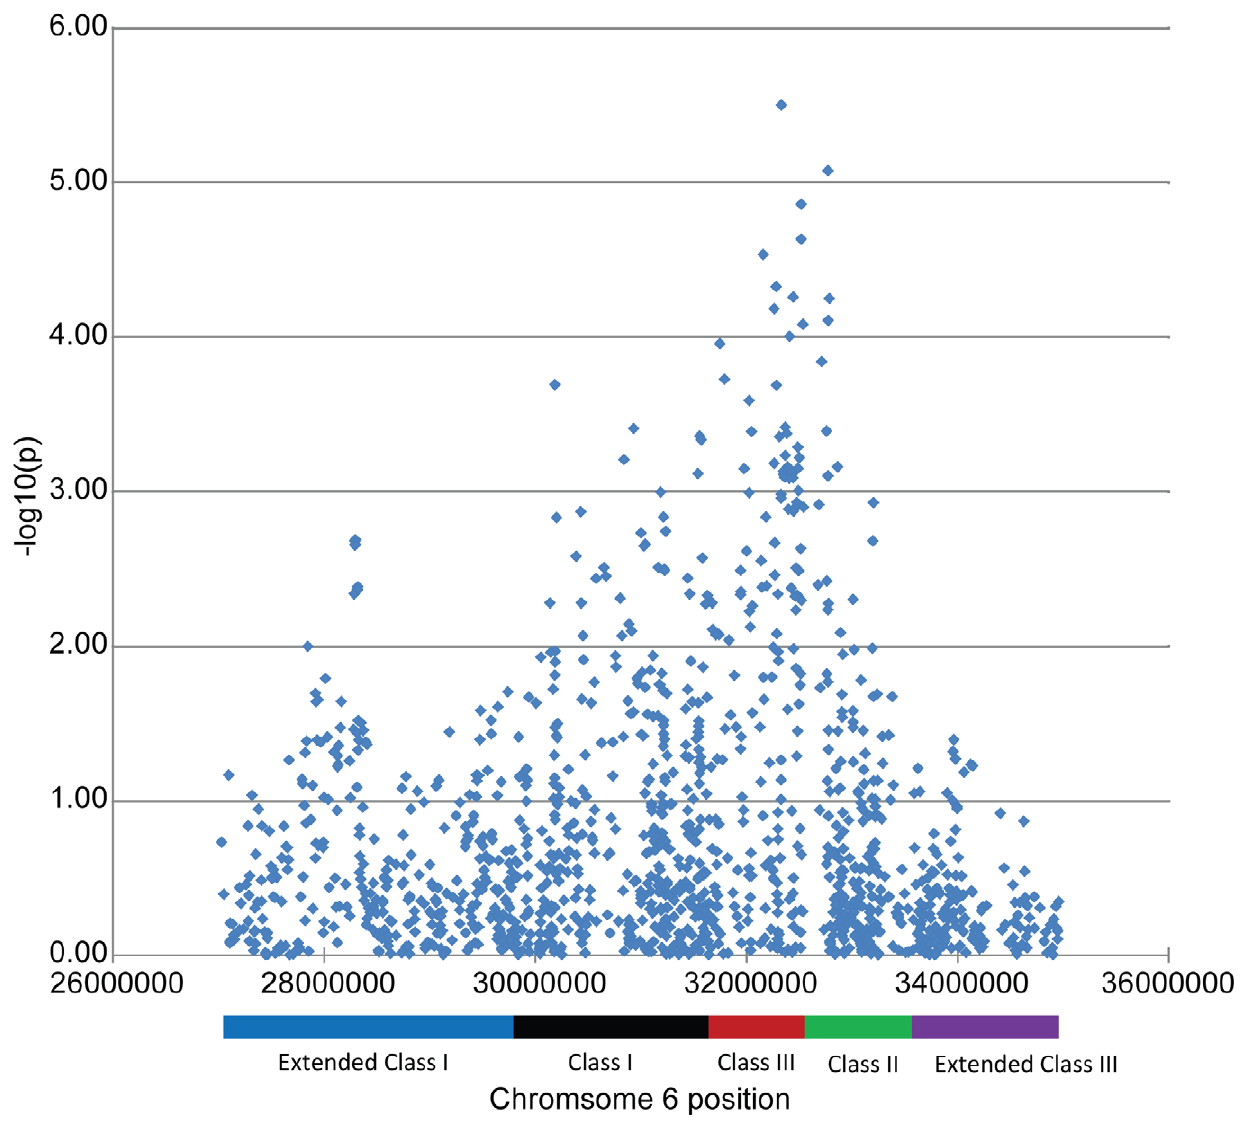
Figure 2. Association results for the MHC SNPs from the case-only analysis.